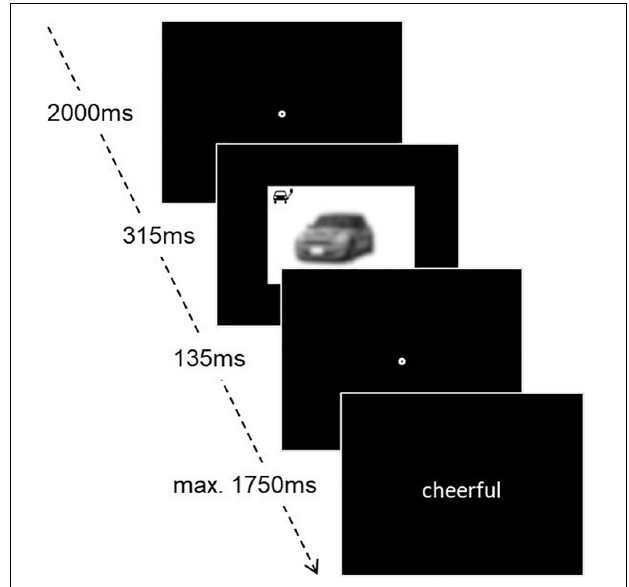
FIGURE 1 | Experimental setup of the affective priming paradigm. The photo of the car has been blurred to grant the anonymity of the brand.